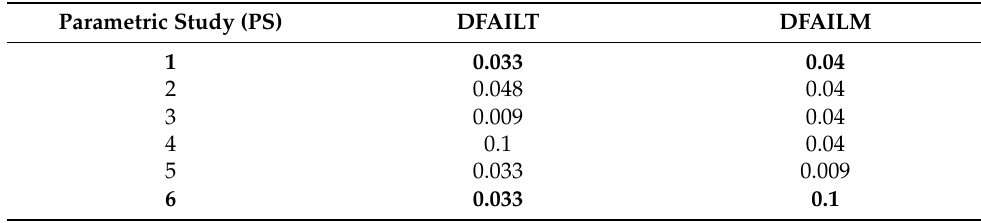
Table 6. Parameters adopted for the parametric